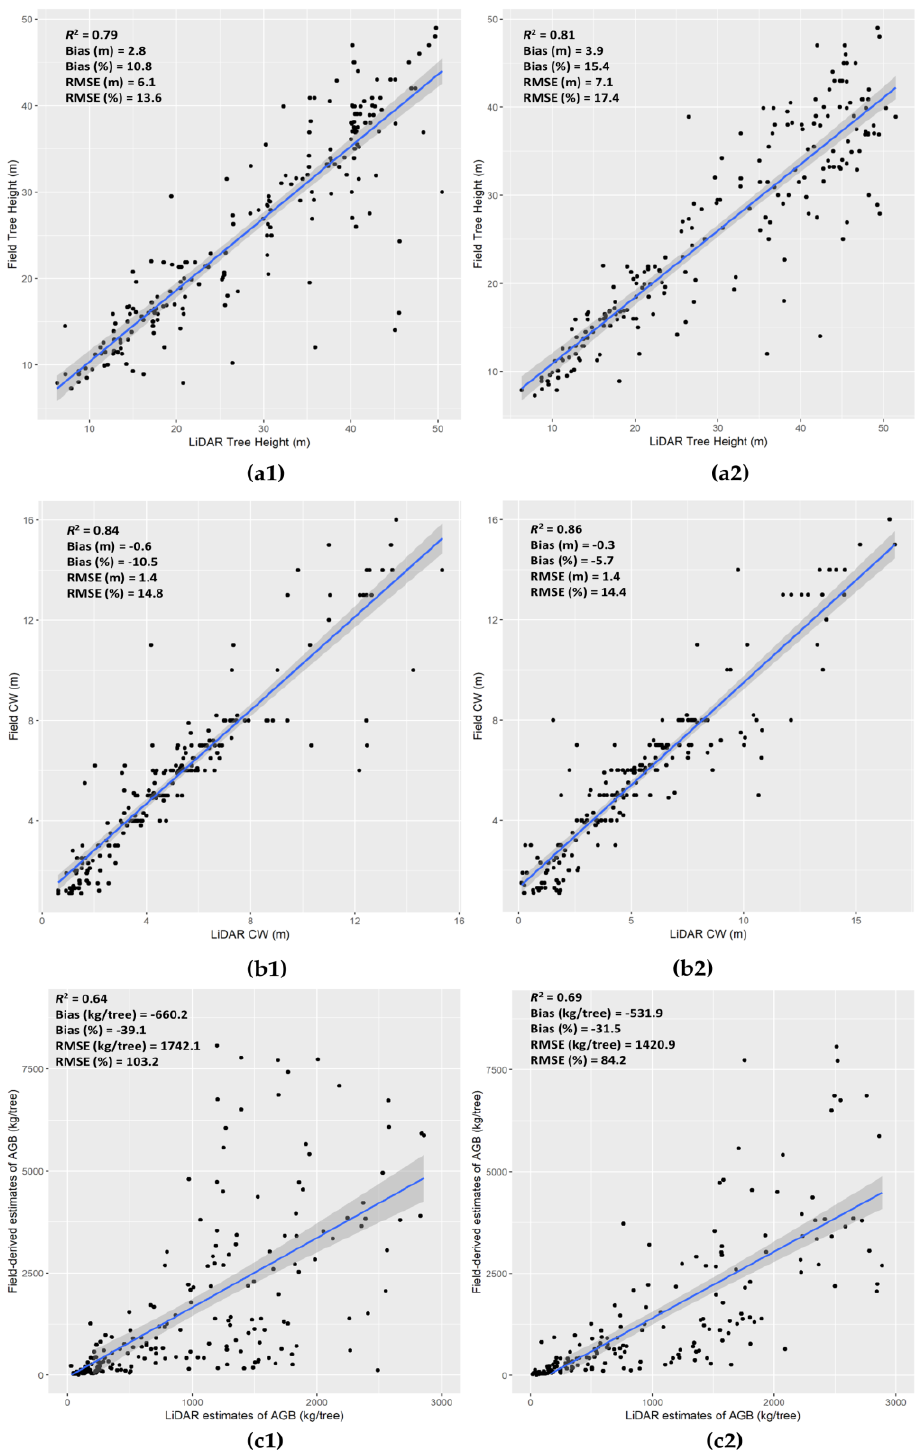
Figure 11. LiDAR-derived tree attributes versus field reference attributes (tree height, crown width (CW), and AGB). ( a1 – c1 ) morphological watershed segmentation results and ( a2 – c2 ) results after refinement with the distance-based algorithm (DBA).